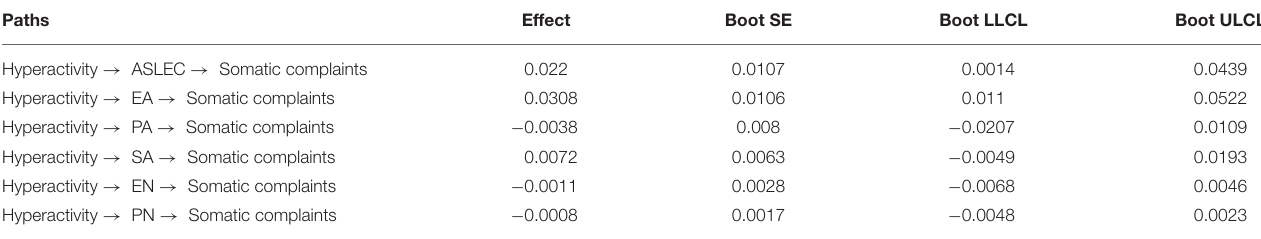
TABLE 4A | Test of the indirect path for different types of childhood trauma and life events mediating the relationship between hyperactivity and somatic complaints. Paths